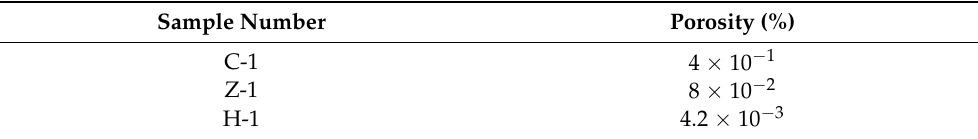
Figure 3. Cross-section µ -CT scanning images of pearl samples showing varying porosity, ( a ) sample H-1; ( b ) sample Z-1; ( c ) sample C-1. Table 3. Porosity outside the nuclear of different pearl samples. Sample Number